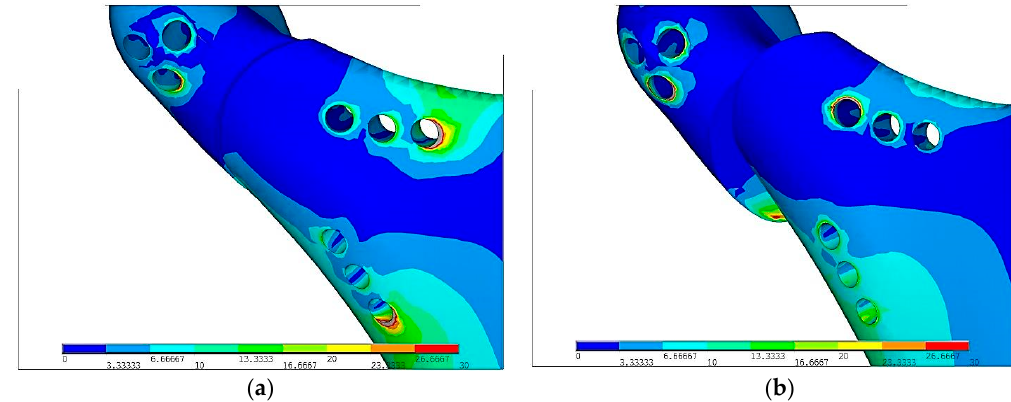
Figure 9. Equivalent stress distribution in mandibular condyle according to von Mises hypothesis just after plate fixation in the maximal loading according to the literature [16]: ( a ) Ti-6Al-4V plate fixation, σ red max = 87MPa, ( b ) PLLa plate fixation, red max = 91MPa; Colors from blue to red means increasing stresses from 0 to maximum.